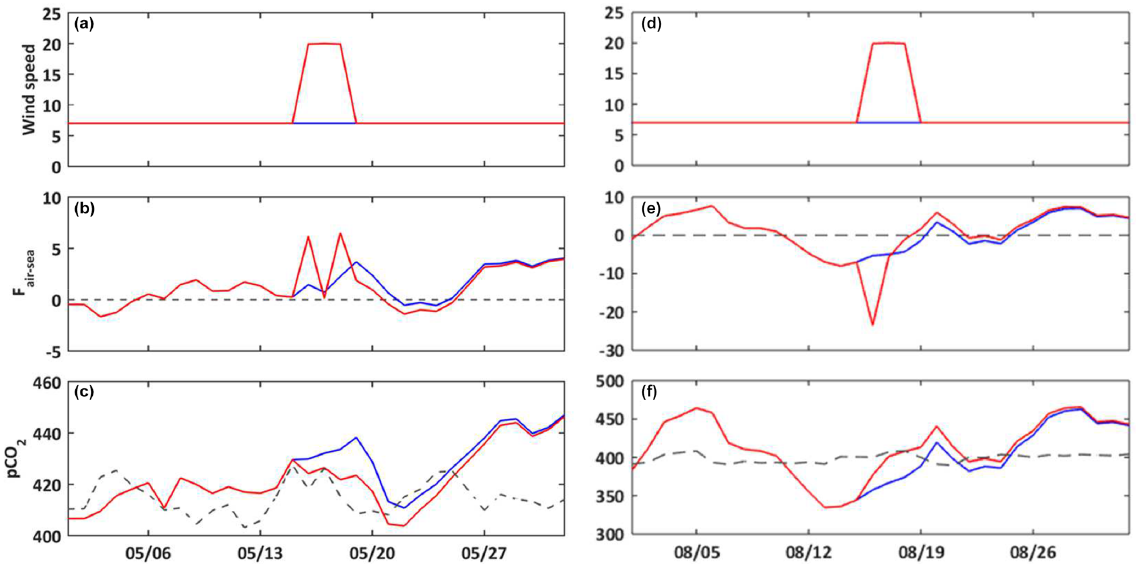
Figure 6. Temporal evolution for May (a–c) and August (d–f) 2017 of the wind speed (ms − 1 , a, d ); air–sea CO 2 fluxes (mmolm − 3 d − 1 , b, e ); seawater p CO 2 (µatm, c, f ). Constant wind scenario ( S 2, blue line) and wind event scenario ( S 3, red line). On (c) and (f) , the dashed line represents the atmosphere p CO 2 (µatm) at the CAV